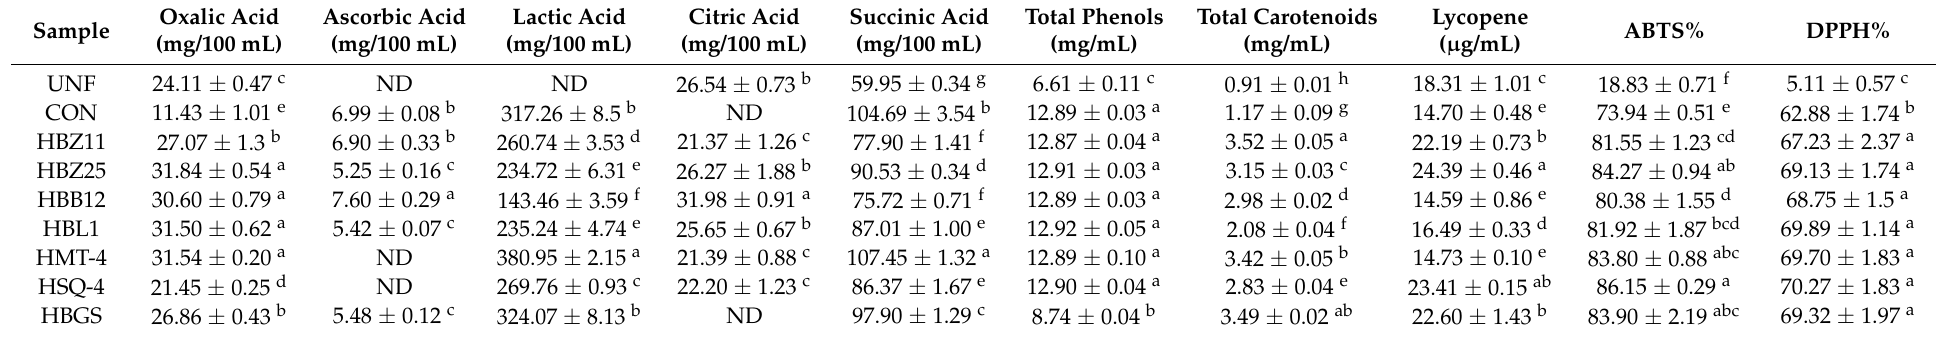
Table 1. Effects of starter on organic acids, total phenols, total carotenoids, lycopene, and antioxidant activity in HST.